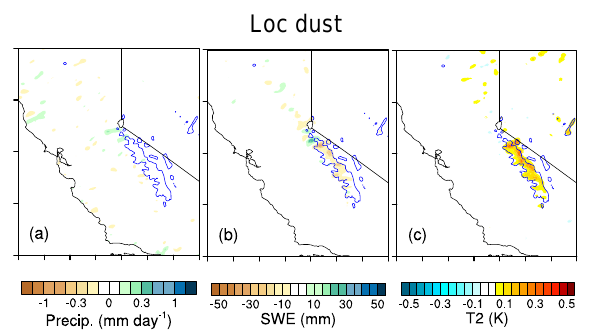
Figure 11. Same as Fig. 10, but for the effect of local dust aerosols (CTRL – NoLocDust).